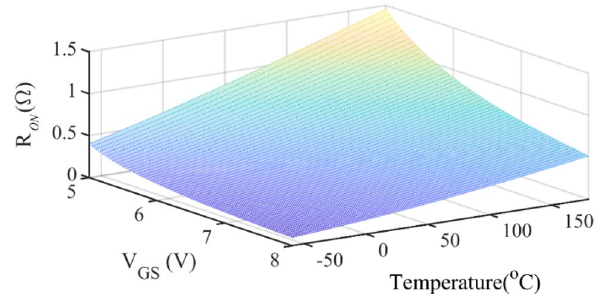
Figure 16. R ON versus VGS and temperature.